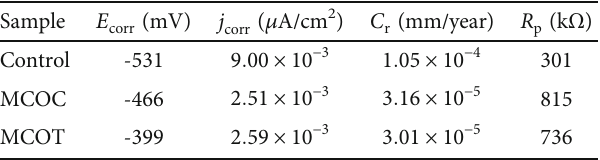
Figure 15: Polarization curves obtained from the control system (red), the MCOC system (dark blue), and the MCOT system (green). Table 2: Corrosion potential data, corrosion current density, corrosion rate, and polarization resistance of the unpainted plate, the control, and the systems containing MCOC and